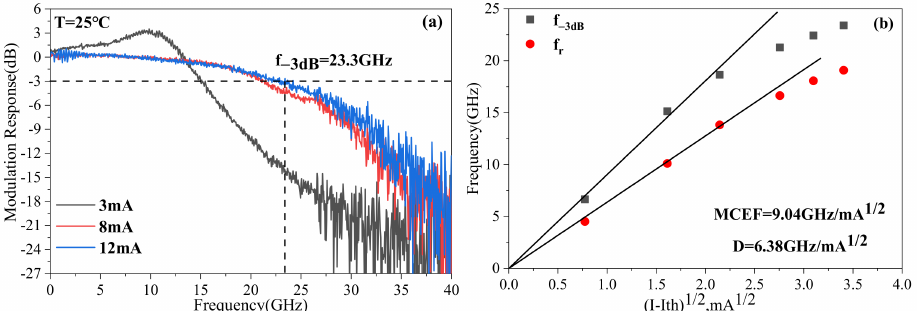
Figure 3. ( a ) Measured small-signal modulation response at different bias currents for the 3 µ m oxide aperture VCSEL, and ( b ) the resonance frequency plotted against the square root of the bias current above the threshold with the D-factor and MCEF